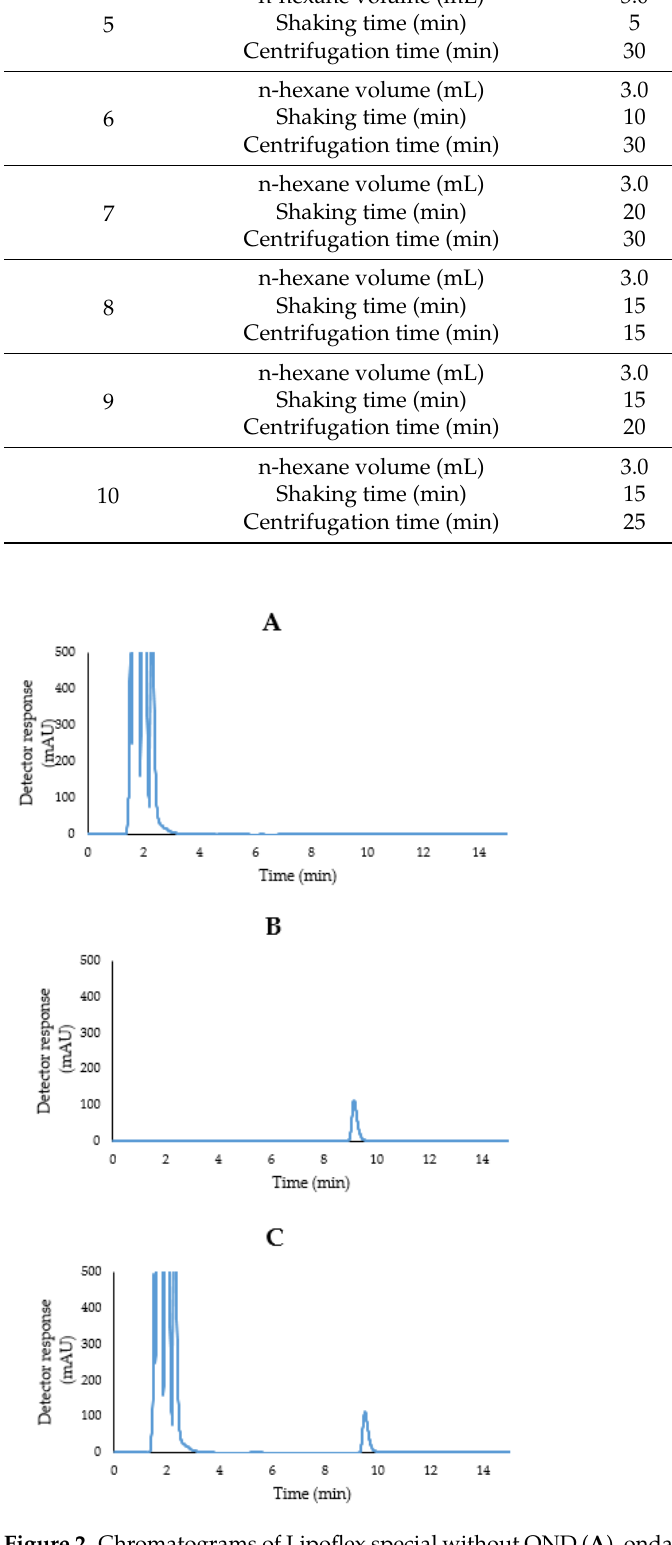
Figure 3. The HPLC chromatograms of forced degradation test. ( A ): 0.1 mol/L hydrochloric acid, ( B ): 0.1 mol/L of sodium hydroxide, ( C ): oxidative stress: 3% hydrogen peroxide, ( D ): high temperature.